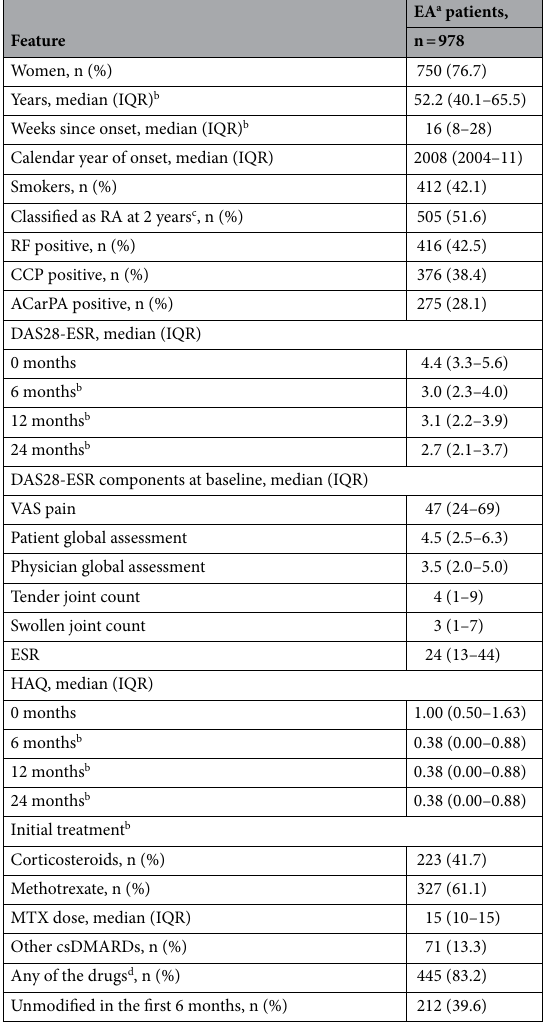
Table 1. Clinical and serological features of the EA patients. a EA = early arthritis; IQR = interquartile range; RF = rheumatoid factor; CCP = anti-cyclic citrullinated peptide antibodies; ACarPA = anti-carbamylated protein antibodies; DAS28-ESR = disease activity score 28 joints; VAS = visual analogic scale; ESR = erythrocyte sedimentation rate; HAQ = Health Assessment Questionnaire; MTX = methotrexate; cDMARD = conventional synthetic Disease-Modifying Anti-Rheumatic Drug. b Incomplete data were available for age (968 patients), weeks since onset (942), smoking (915), DAS28-ESR at 6 months (637), 12 months (519) and 24 months (504); HAQ at baseline (949), 6 months (665), 12 months (617) and 24 months (654); and for initial treatment (535). c Classified according to the 1987 ACR classification criteria. d The other drugs = corticosteroids or MTX or other